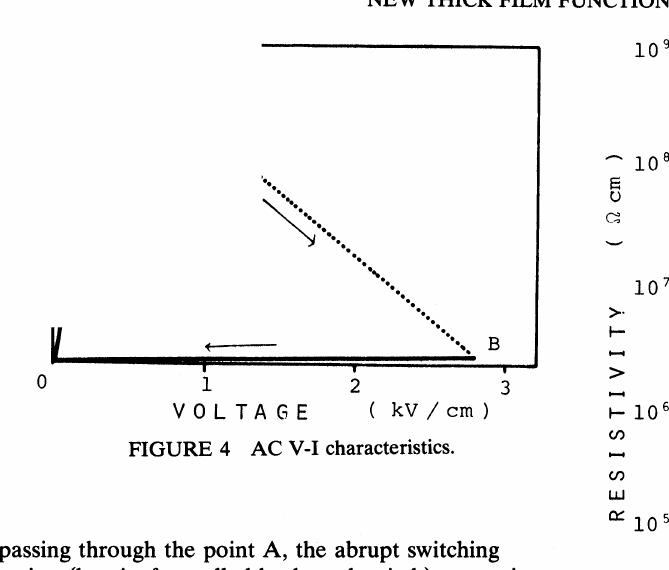
FIGURE 4 AC V-I characteristics.